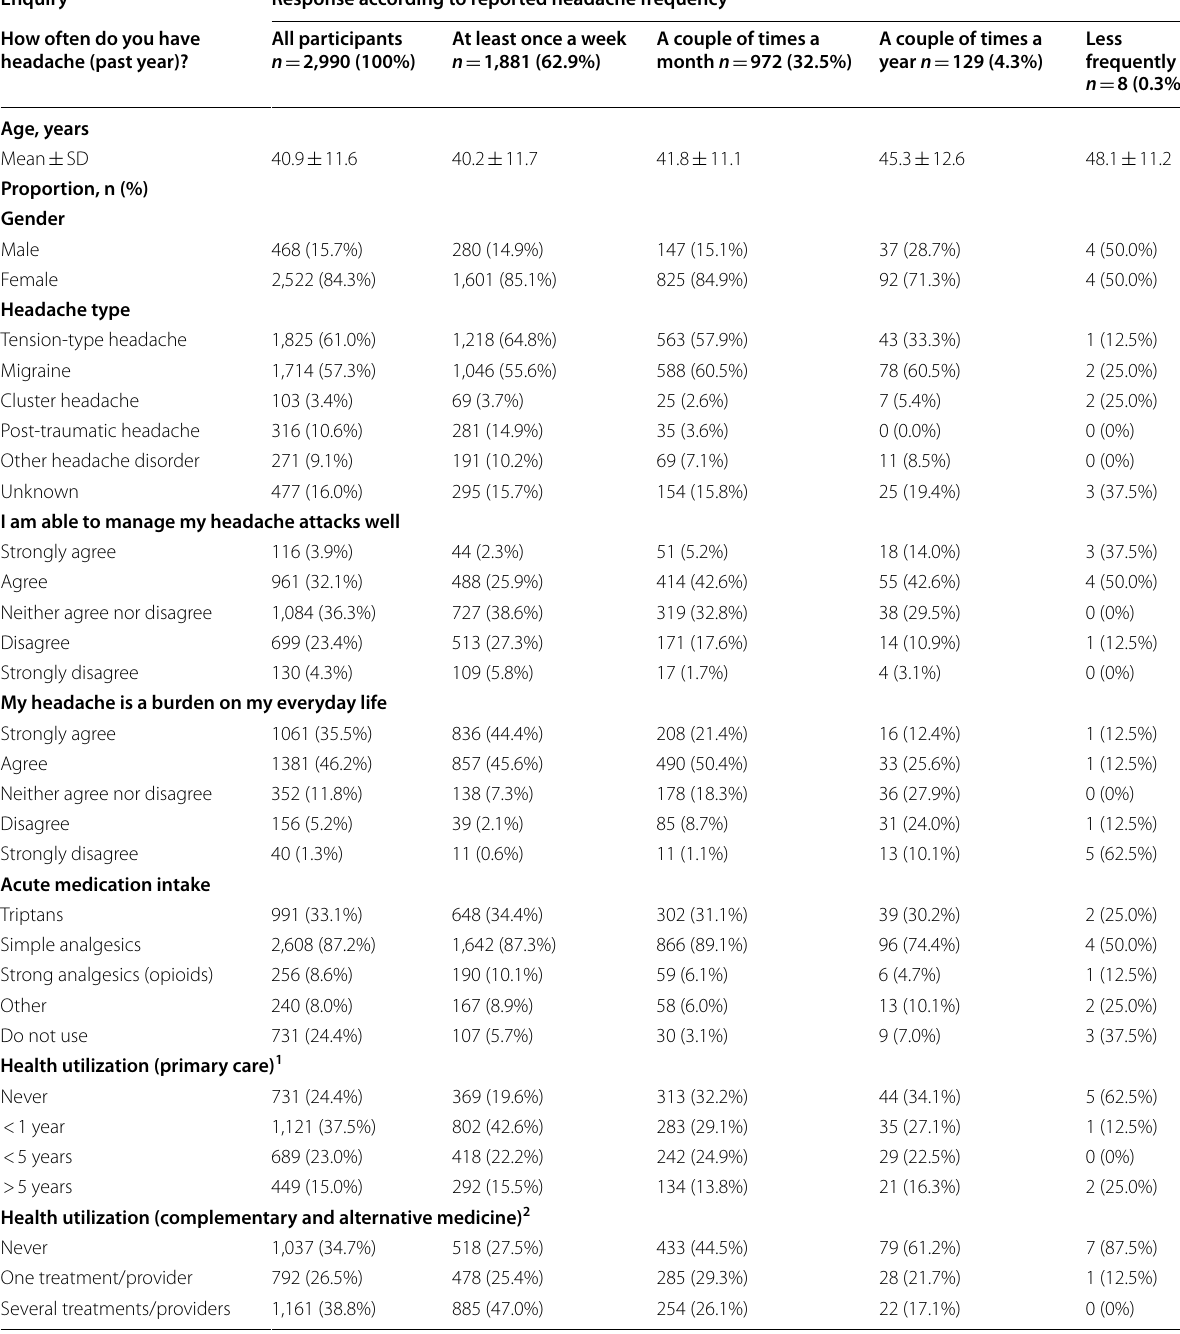
Table 3 The healthcare utilization